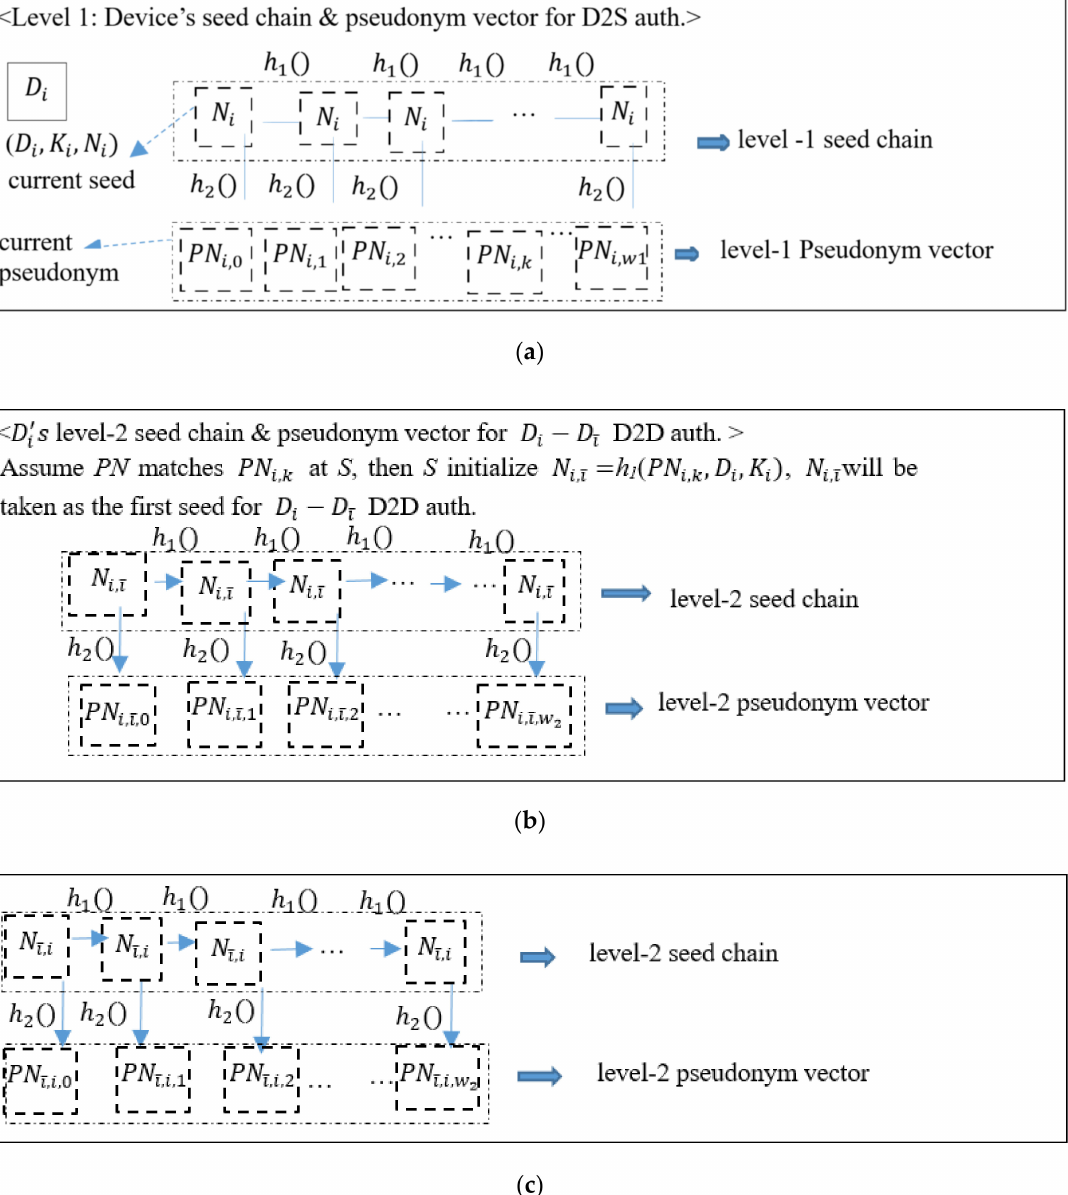
Figure 1. ( a ) D i ’s level-1 seed and pseudonyms; ( b ) D i ’s level-2 seed and pseudonyms for D i − D D ’s level-2 seed and pseudonyms for D i